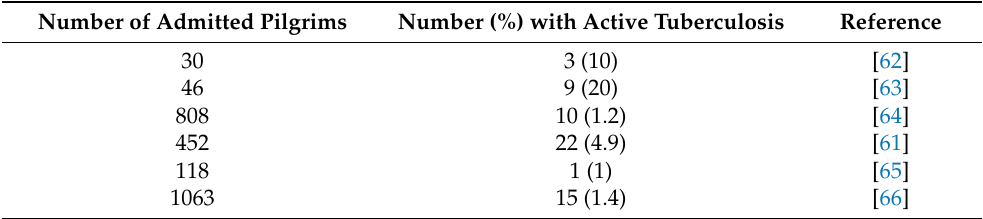
Table 3. A summary of studies describing active tuberculosis among